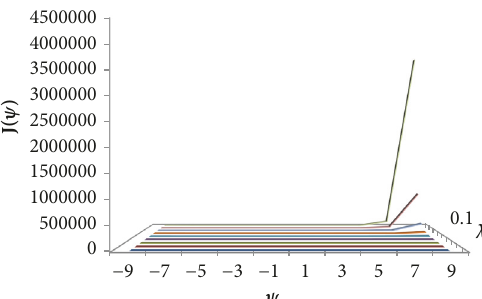
Figure 6: Graph of expected present value of the utility of asset 𝐽(𝜓) versuscontrol 𝜓 and rateof return on capital asset 𝛽 while subjective discount rate 𝜂 and degree of relative risk 𝜆 are fixed at 0.1 and 0.9 , respectively.